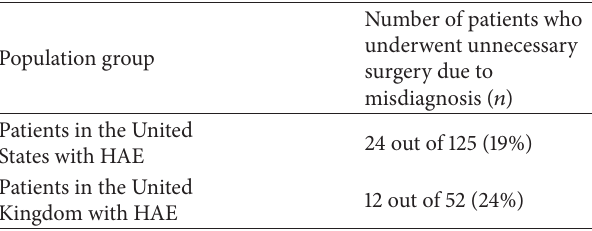
Table 2: Key findings of an international Internet based survey of HAE patients in relation to surgical